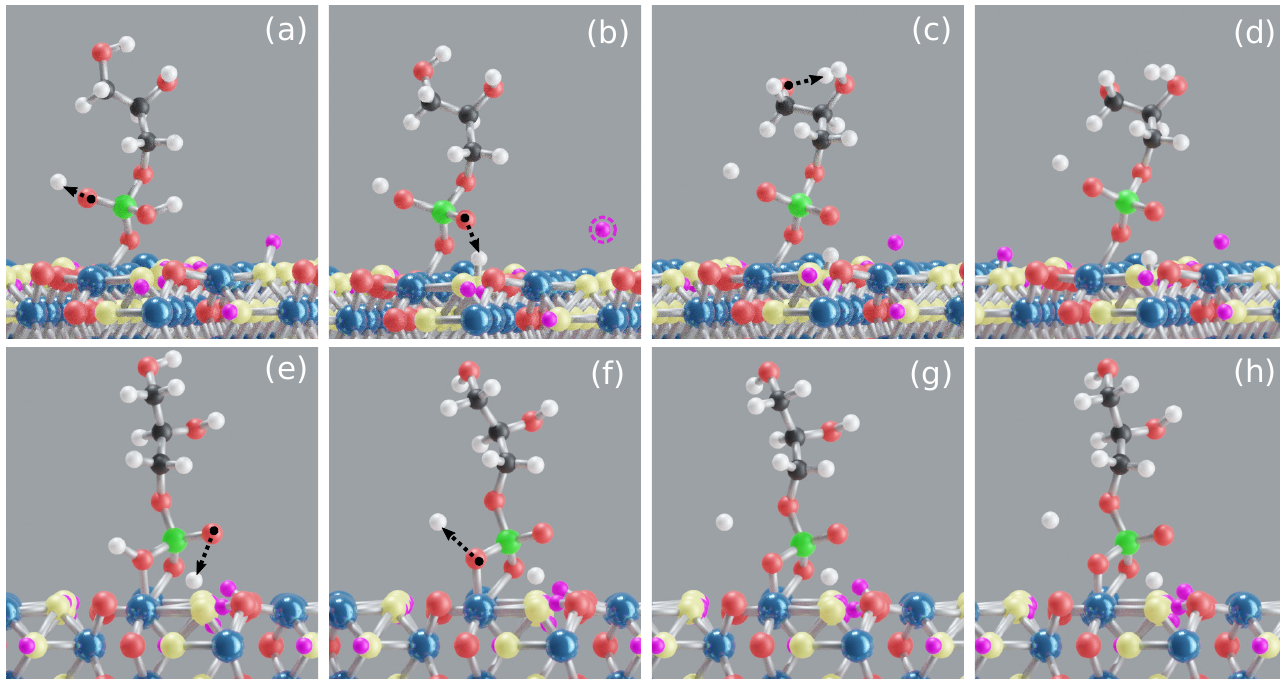
Figure 3. Snapshots of goethite–GP–water models along the simulation trajectory. Proton transfer from GP to water ( a ), a proton transfer from GP to surface and from surface to water ( b ), a proton transfer from GP to water ( c ), a stable M motif at 25 ps ( d ), proton transfers from GP to water ( e , f ), and B motif at 20 ps ( g ) and 25 ps ( h ). As proton transfer events are common in these interactions, the goethite surface hydrogen atoms and GP’s hydrogen atoms are shown in violet and white colors to avoid confusion. Moreover, the surrounding water is ignored here for better visualization. Snapshots ( a , b , e , f ) are from equilibration